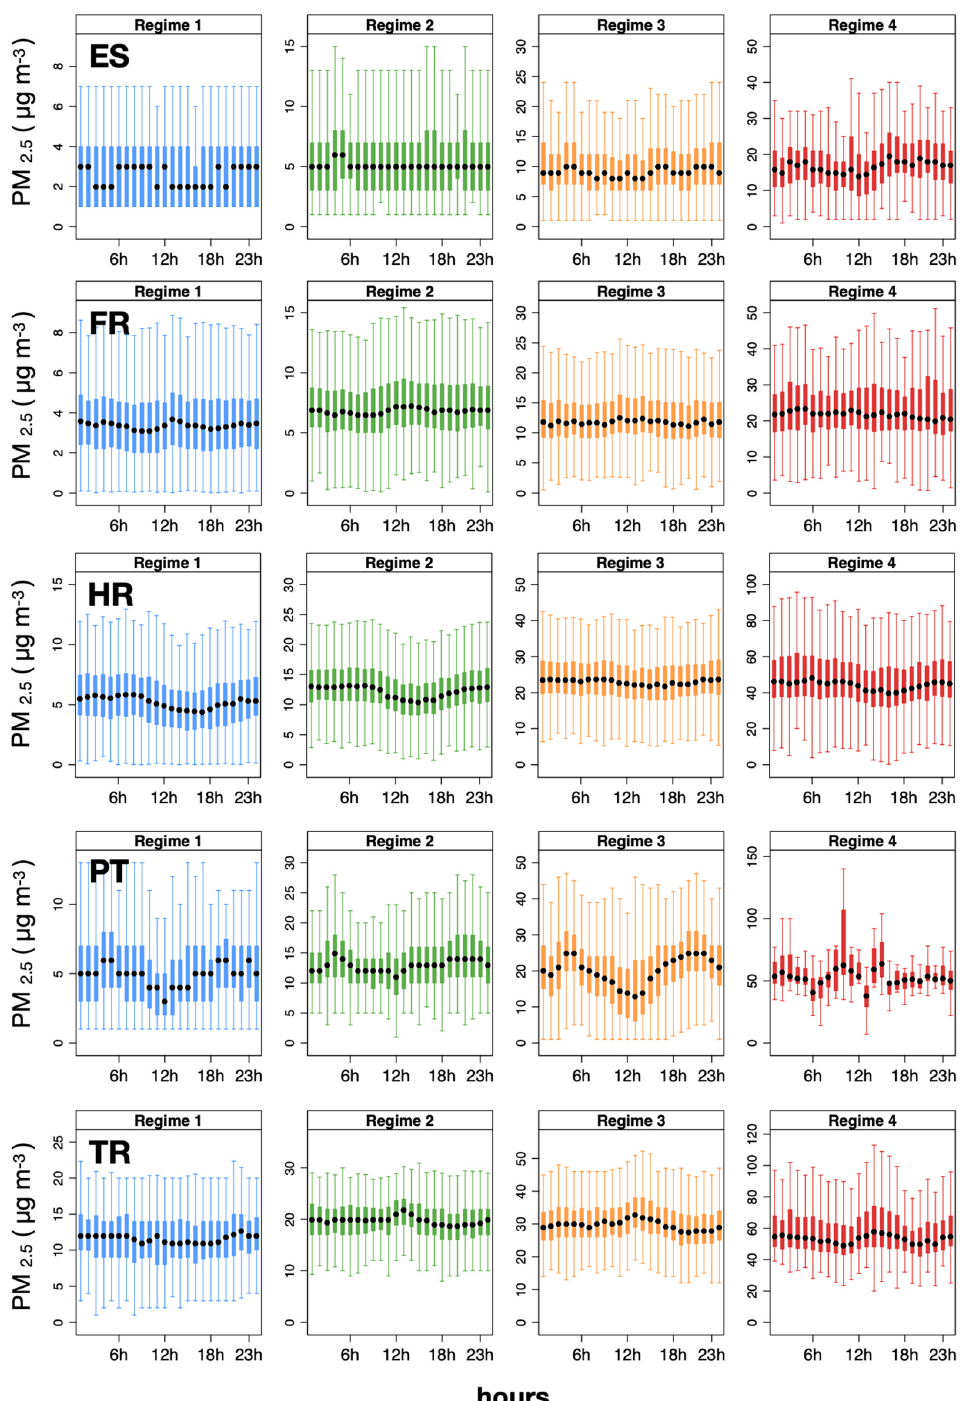
Figure 7. Evolution of the PM 2.5 concentration by regimes and hour of the day as in Figure 4.